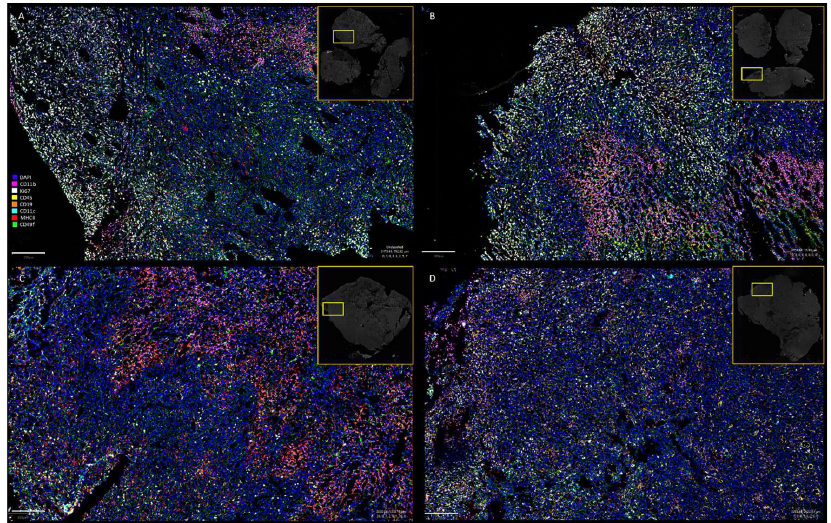
Figure 3. Multiplexed immunohistochemistry of tumor tissue sections of antibiotic-treated (ABT) and untreated mice after either bacteria (EcN) or PBS intranasal injections. The probes were stained with Ki67, CD11b, MHCII, CD19, CD11c, CD45 and CD49f antibodies and DAPI nuclear staining. ( A ): PBS— PBS-injected group; ( B ): ABT PBS —antibiotic-pretreated and PBS-injected group ; ( C ):